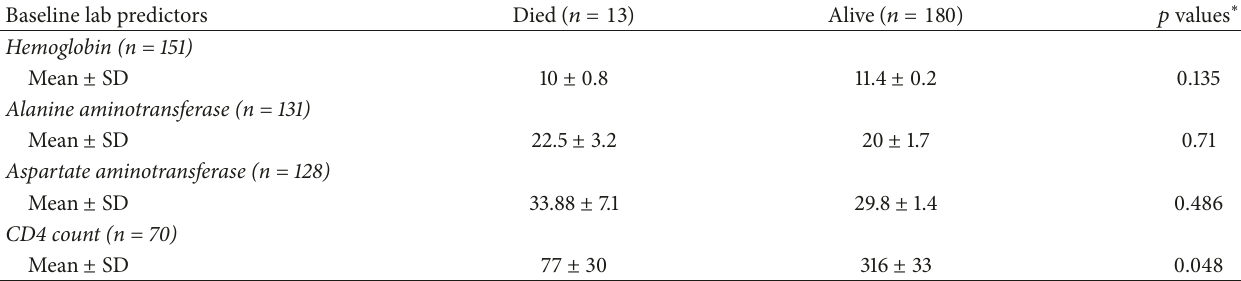
Table 4: Hematological and clinical biochemistry predictors of MDRTB mortality.